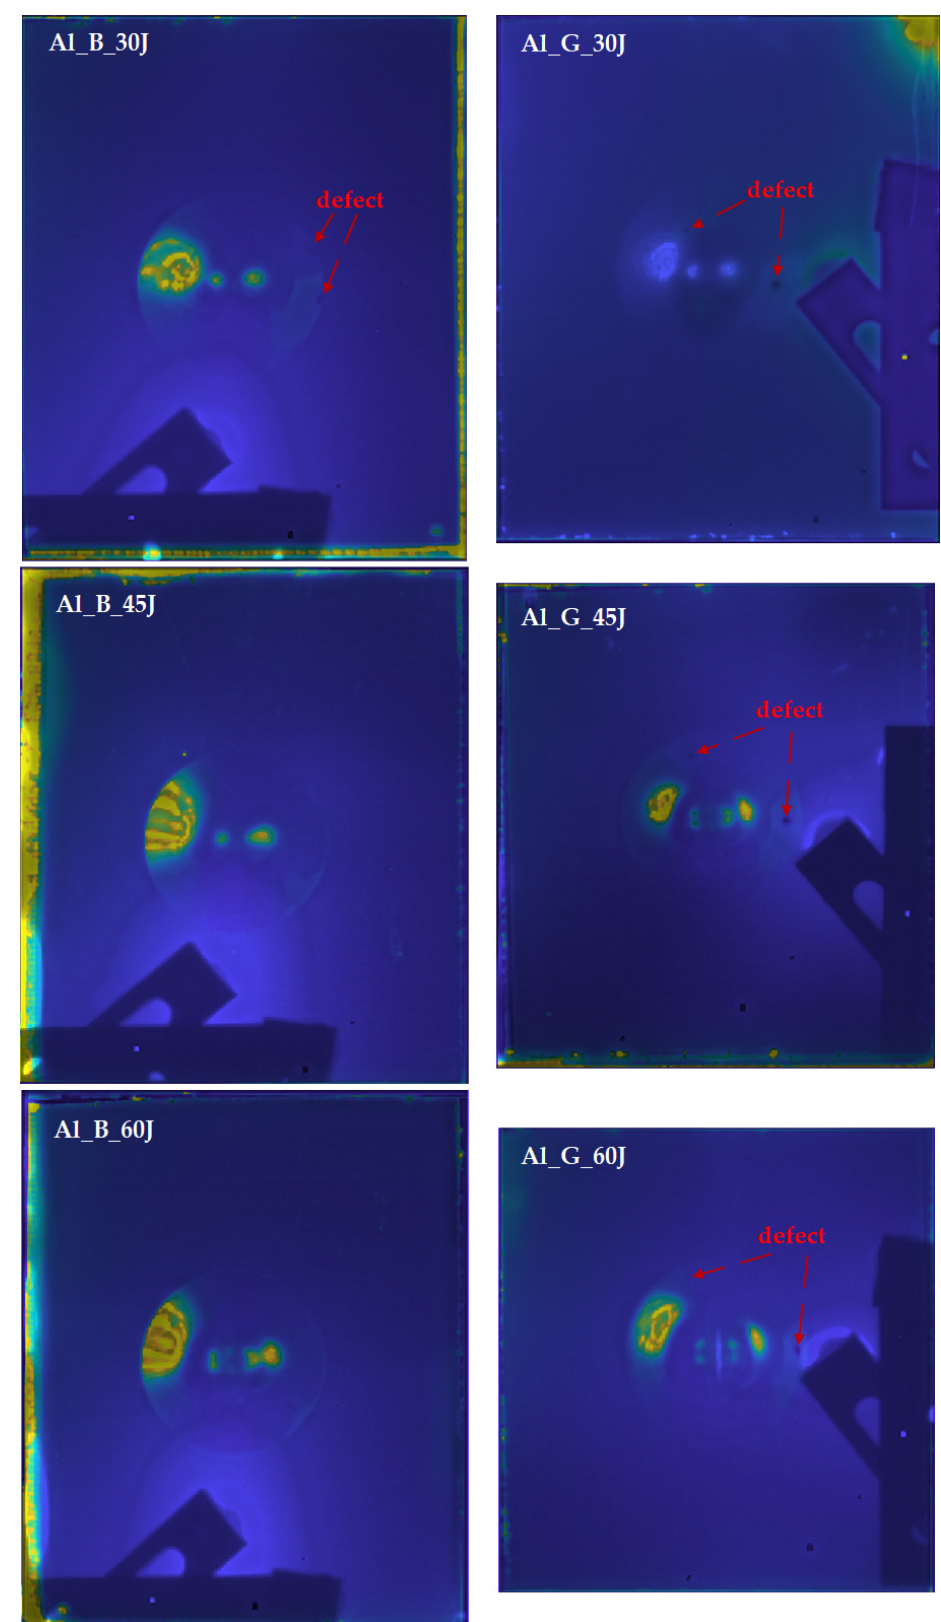
Figure 14. Fusion results of the proposed FE ‐ S ‐ F framework on six FMLs samples.